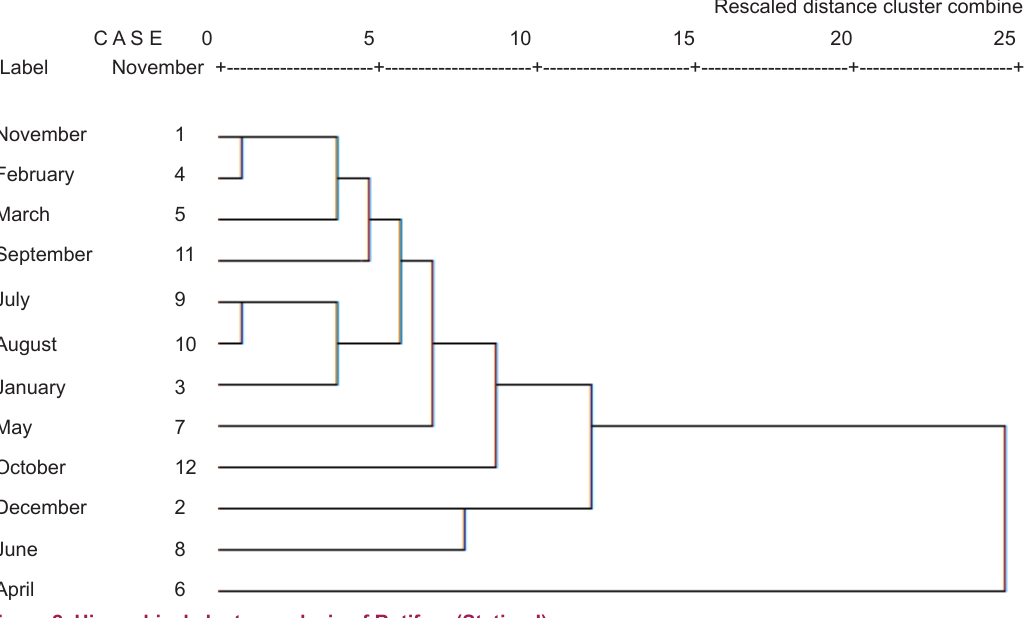
Figure 2. Hierarchical cluster analysis of Rotifera (Station I)